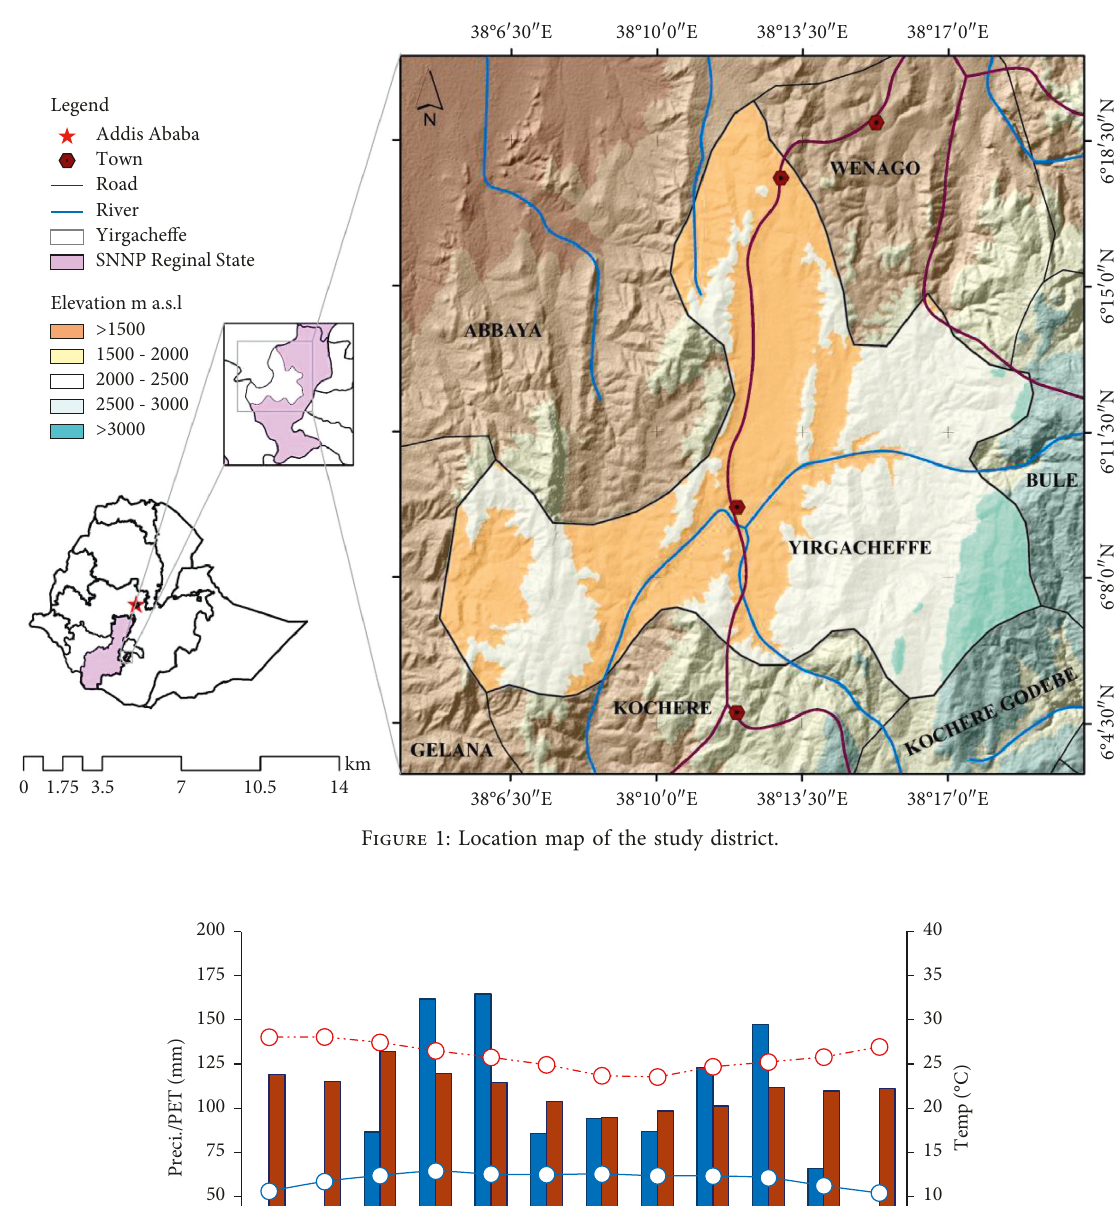
Figure 2: Monthly average precipitation (mm) and monthly maximum, minimum, and average temperature ( ° C)